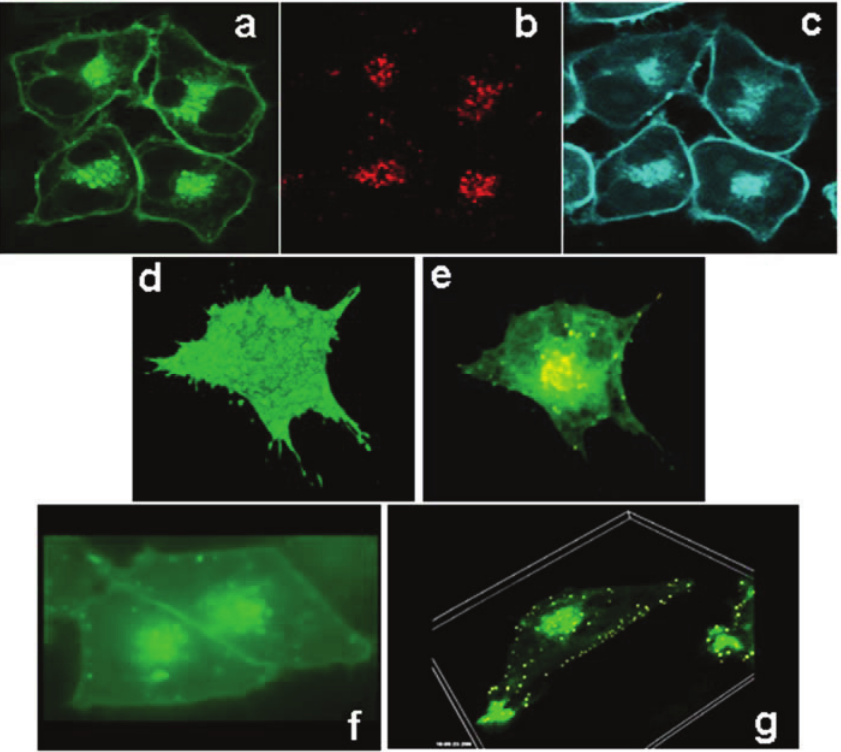
Figure 2. ABCG1-GFP traffics between the cell surface and late endosomes. ABCG1-GFP resides on the cell surface and intracellular vesicles ( a ; green ), vitally labeled with endocytosed Alexa594 dextran ( b ; red ), used as a marker for late endosomes/lysosomes. As seen in ( c ), the ABCG1 late endocytic vesicles are enriched with cholesterol as revealed by cholesterol-specific cytochemical filipin staining ( blue ). 3D reconstruction of the entire volume of an ABCG1-expressing cell shows ABCG1 in the cell surface ( d ; single frame from Movie 1). Rendering of the data set in ( d ) to reveal intracellular ABCG1 ( e ) demonstrates the colocalization of ABCG1 ( green ) in late endosomes, labeled as in ( b ) with fluorescent dextran ( red ), as yellow punctate structures in this merged image. Note the ABCG1 late endosomes/lysosomes localize in abundance in the perinuclear region as well as in peripheral locations close to the cell surface ( e ; single frame from Movie 2); ( f ) Time lapse confocal microscopy reveals trafficking of ABCG1-late endosomes between the perinuclear region and cell surface as well as contact of ABCG1-late endosomes with each other and the PM (Single frame from Movie 3); ( g ) 3D-Time lapse confocal microscopy shows extensive interaction of ABCG1 late endosomes with the cell surface (Single frame from Movie